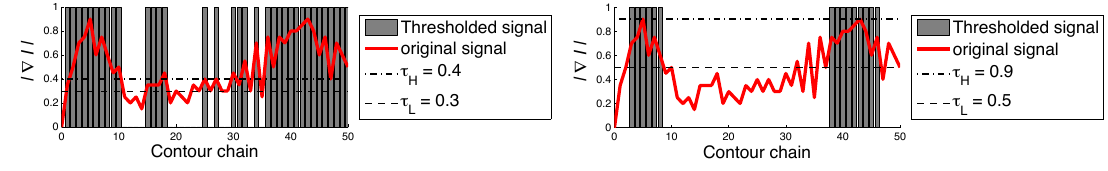
Figure 2. Example of hysteresis threshold applied along a contour